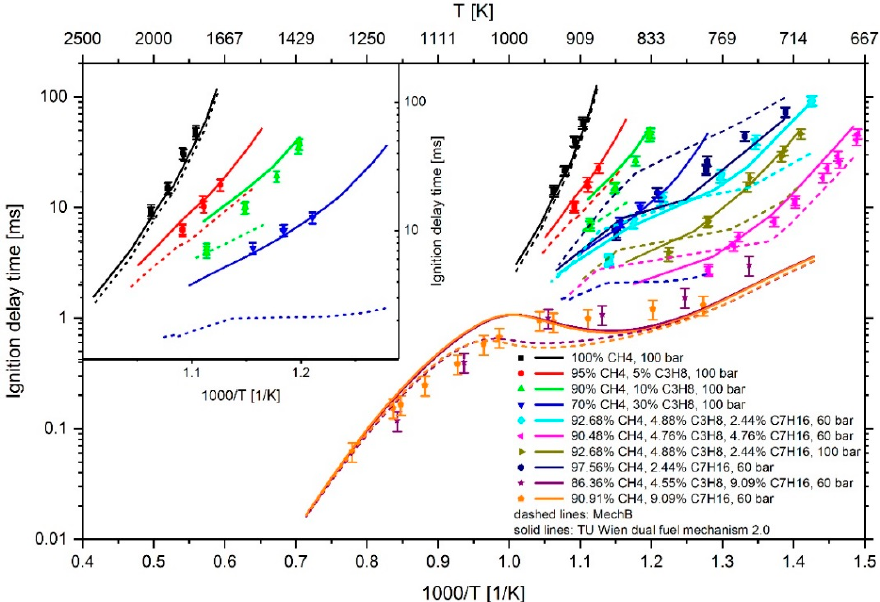
Figure 22. Experimental data (symbols) [12,13] versus model prediction (lines) using the mechanism MechB (dashed lines) and the final TU Wien dual fuel mechanism 2.0 (solid lines). The diagram in the upper left corner highlights the comparison between measured and calculated IDTs of methane–propane mixtures. The respective content of methane, propane, and n -heptane is given in mol% and corresponds to the values in Table 1.